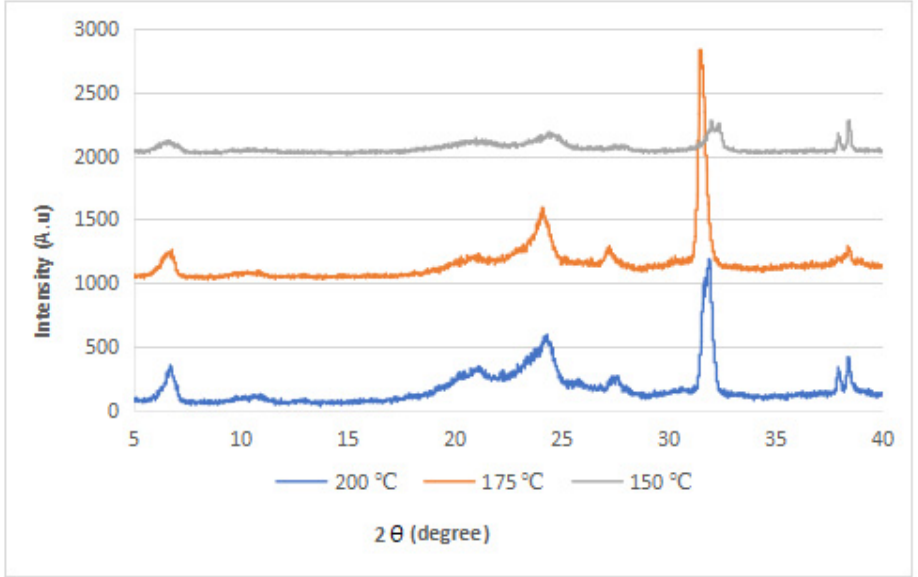
Figure 8. XRD Spectra for Nylon 610 Nanocomposites with 1.5 wt% Treated Graphite Flakes at All Temperatures for the Supercritical Water Treatment .